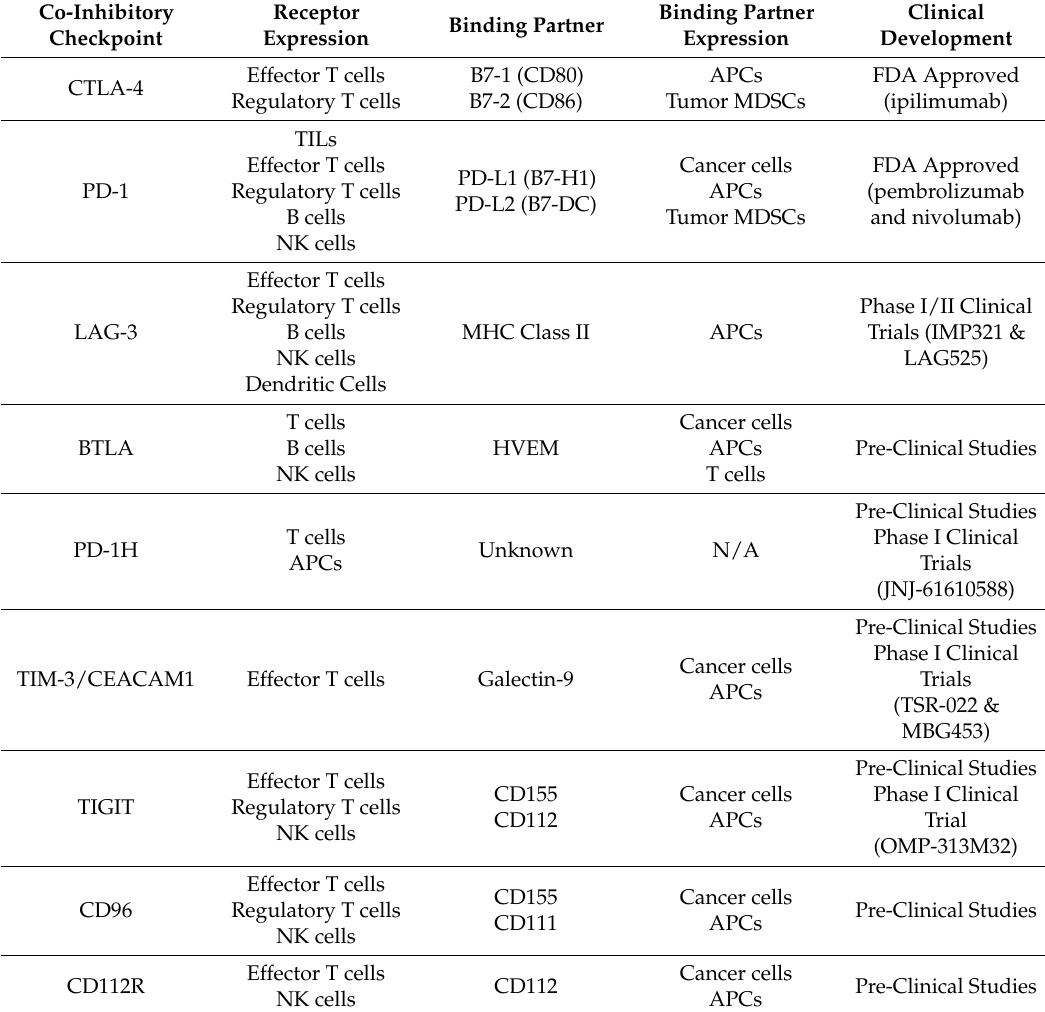
Table 1. Summary of co-inhibitory immune checkpoint